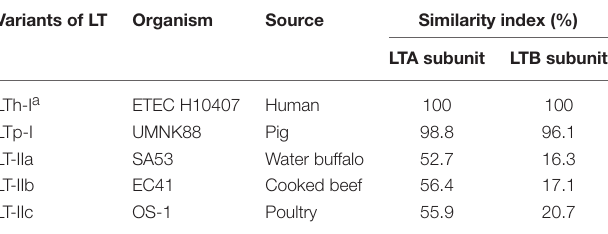
TABLE 1 | Organism, source, and similarity index of variants of